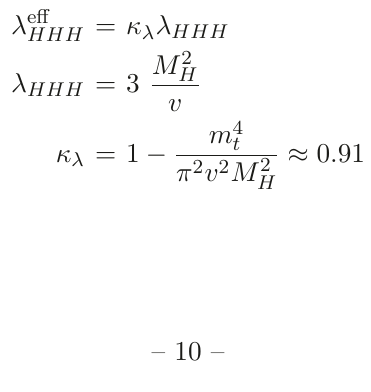
JHEP10(2022)185